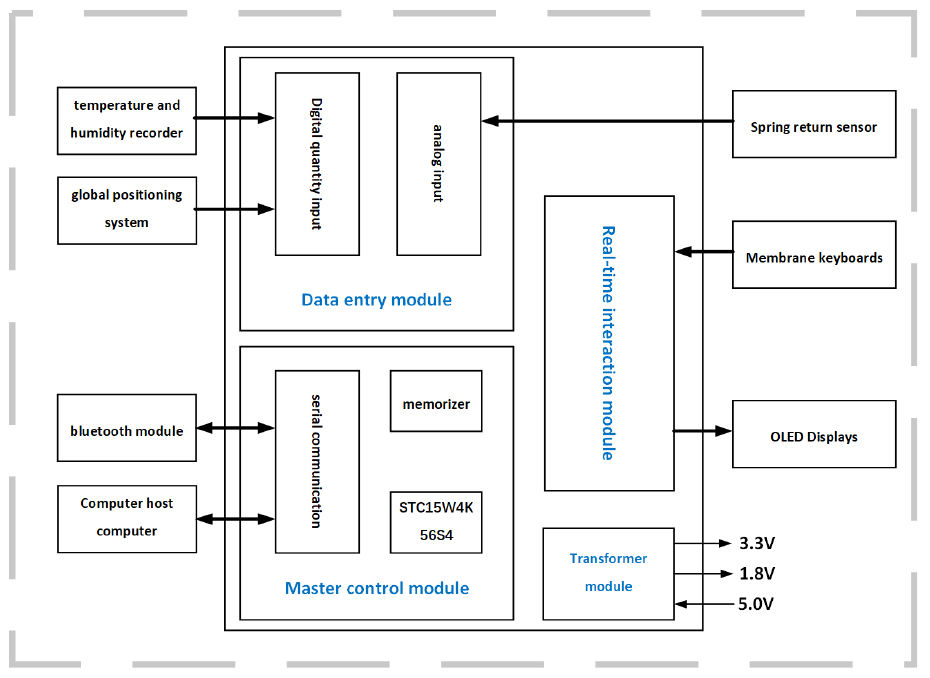
Figure 2. Frame diagram of the circuit structure.